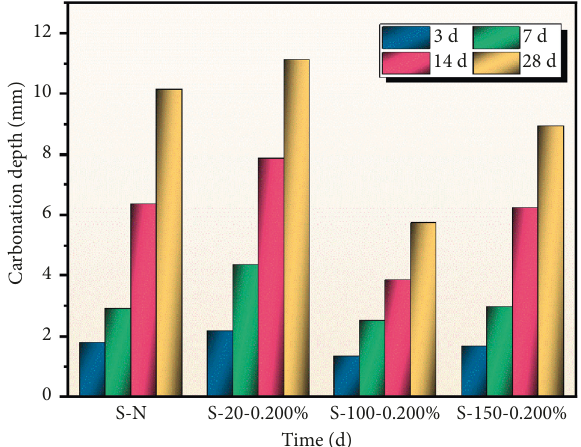
Figure 6: Carbonation depth of concrete with SAP of different sizes. (Figure 10(a)) and S-100-0.200% (Figure 10(b)) (optimal group in carbonation test) were investigated and com- pared, whose age ranged from day 3 to day 56. At the same